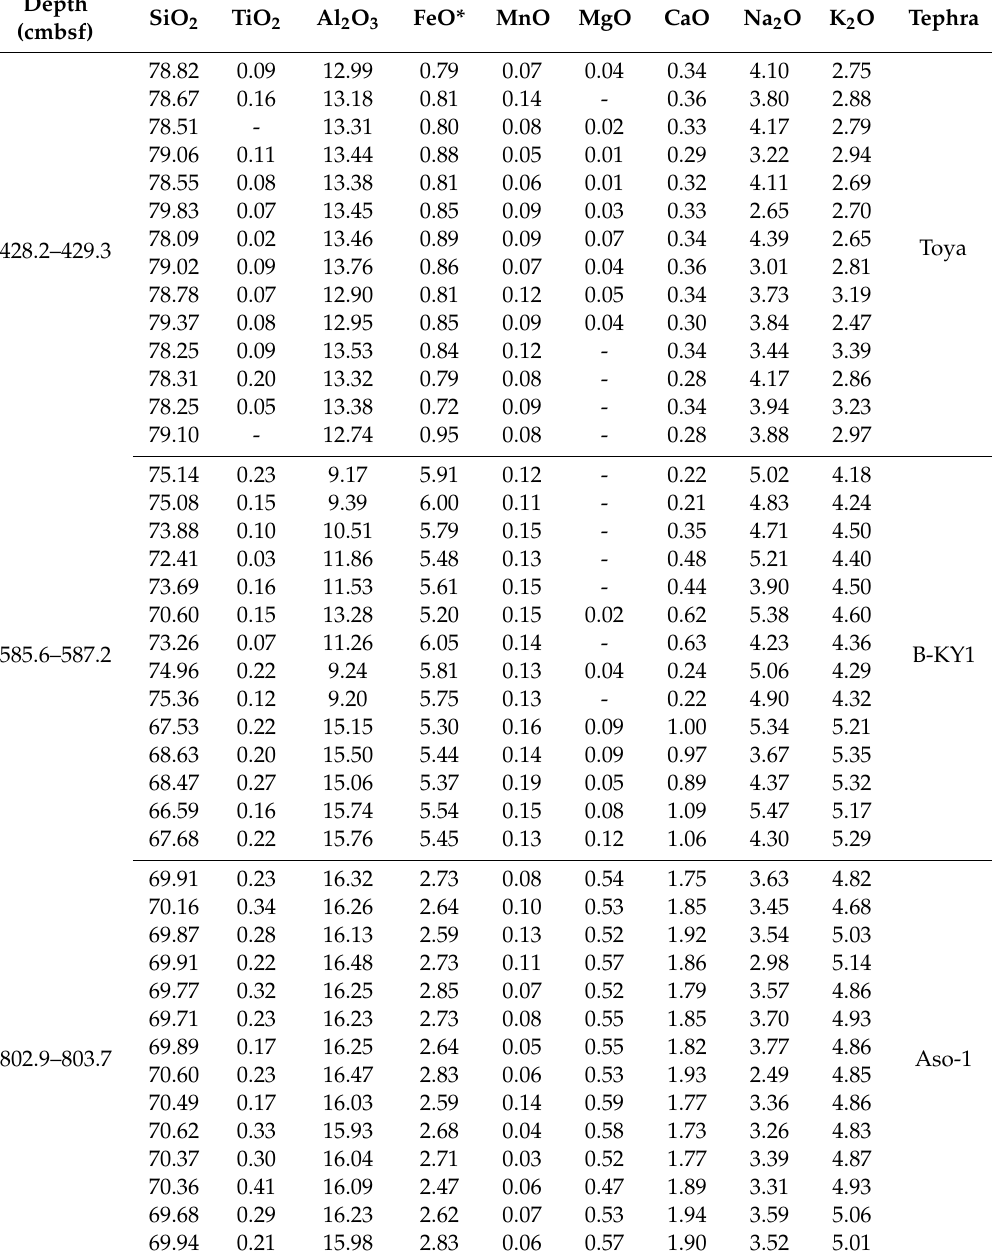
Table 2. Major elements of Toya, B-KY1, and Aso-1 tephra samples from the ODP 794A core. Normalized to 100 wt.%. FeO*: Total Iron. cmbsf: cm below